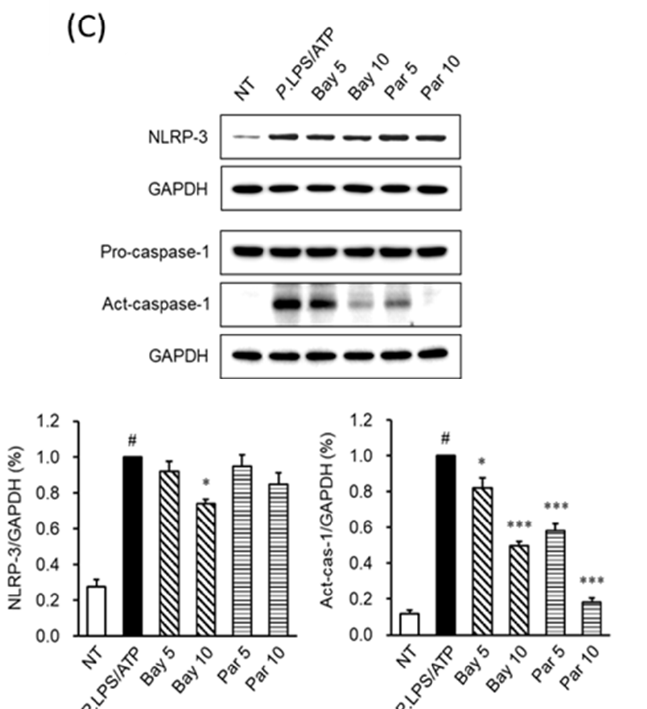
Figure 4. The effect of BITC on NF- κ B activation in P. aeruginosa LPS-stimulated THP-1 cells. ( A ) The cells were pretreated with BITC (1, 10, and 30 µ M) for 1 h and then stimulated with P. aeruginosa LPS for 1 h. Cytosol protein extracts were prepared as described in the materials and methods and evaluated for phosphorylation of IkB α using western blot analyses. Nuclear protein extracts were prepared and analyzed for NF- κ B nuclear translocation using western blot analyses. ( B ) After stimulation with P. aeruginosa LPS/ATP for 24 h in the presence or absence of Bay 11-7082 (1, 5, and 10 µ M) and parthenolide (1, 5, and 10 µ M) for 1 h, IL-1 β production by THP-1 cells was determined via ELISA. ( C ) After treatment with LPS/ATP in the presence or absence of Bay 11-7082 and parthenolide for 1 h, NLRP3 (LPS for 3 h) and caspase-1 (LPS for 1 h) protein expression were determined using western blotting. GAPDH was used as an internal control for the western blot analyses. Each value indicates the mean ± SD and is representative of results obtained from three independent experiments. # p <0.05 vs. untreated group; * p < 0.05, ** p < 0.01 and *** p < 0.001 vs. P. aeruginosa LPS group. NT, untreated group; Bay, Bay 11-7082; Par, parthenolide.